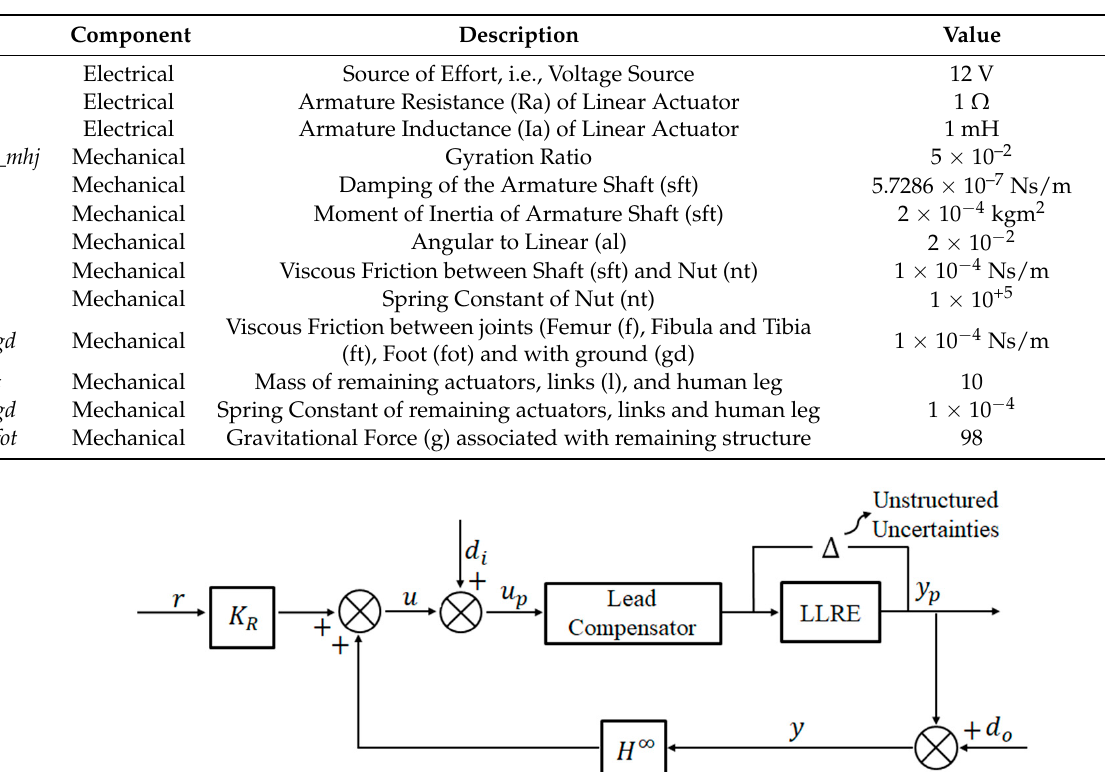
Table 1. Variables of the composite model and their details.